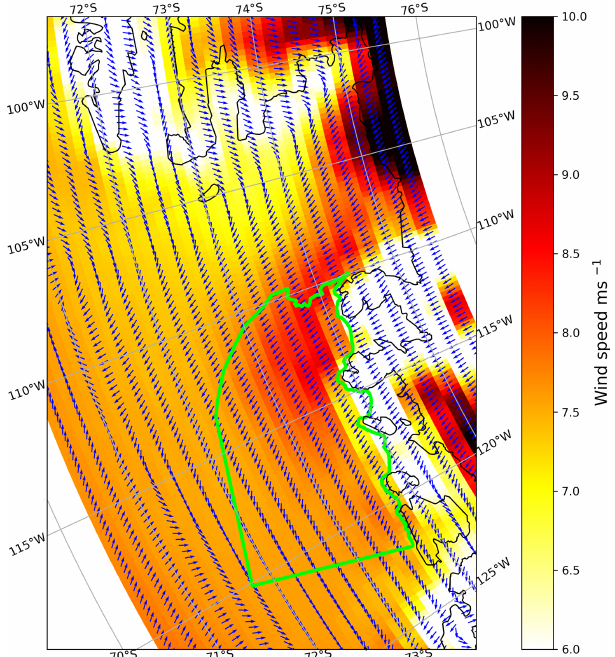
Figure 9. Annual mean vector wind field and wind speed, calculated for the period 1 November 2016 to 31 December 2020. The green boundary represents the ASP study area, also shown in Fig. 1b. Daily maps of vector wind fields and wind speed are included as Video